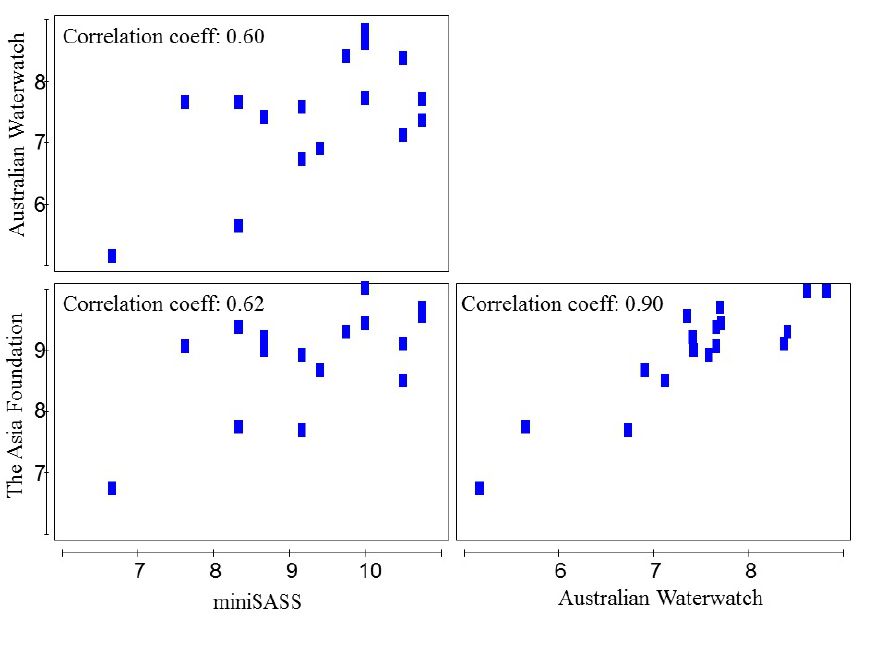
Figure 4. Correlation values between three index